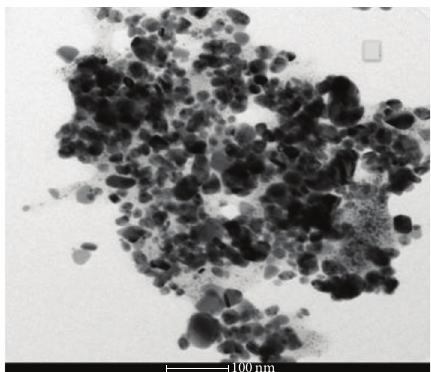
Figure3:RepresentativeTEMimageofAg NPssynthesizedatroom temperature using latex extract from the stems of fresh fruits of Thevetia peruviana [45] (reproduced with permission from